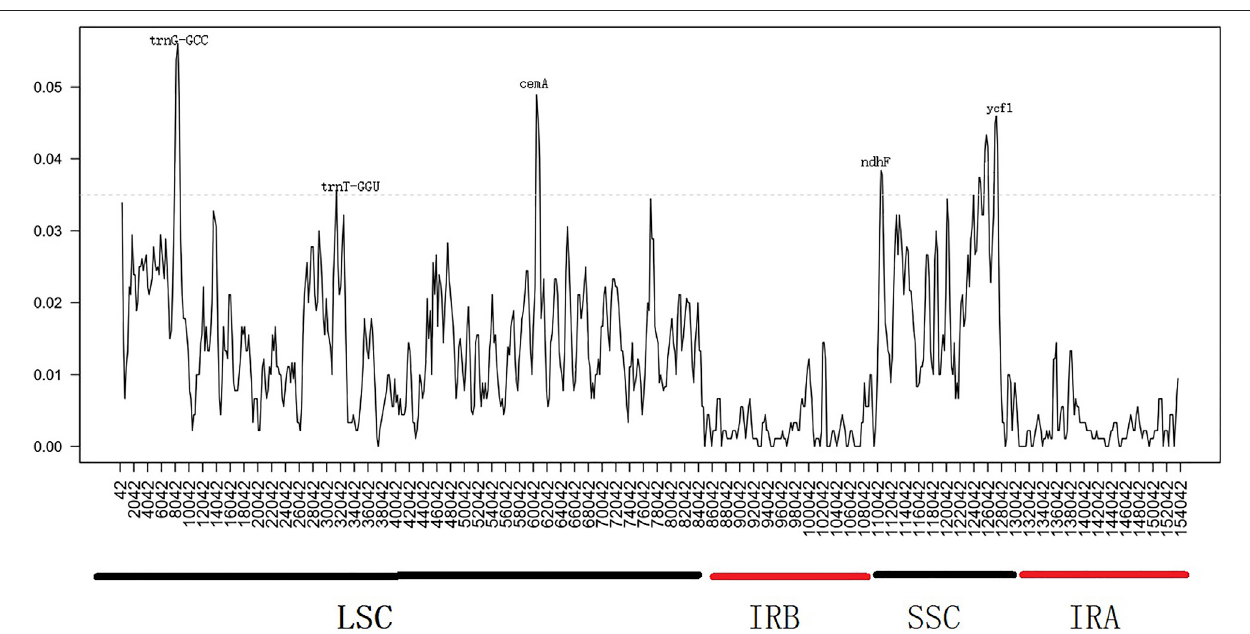
FIGURE 7 | Sliding window analysis based on the chloroplast genomes of three Balsaminaceae species. Window length: 2000 bp; step size: 200 bp. X-axis: the position of the midpoint of a window. Y-axis: nucleotide diversity of each window.